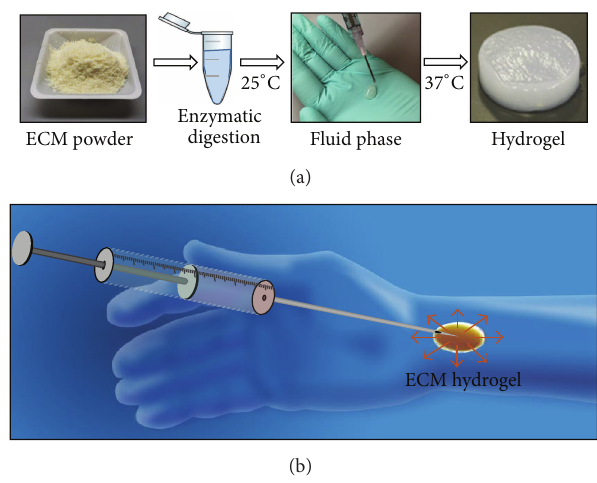
Figure 5: Minimally invasive delivery of ECM-based hydrogels. (a) ECM-derived hydrogels can be manufactured via enzymatic digestion of powdered ECM in an acidic 1mg/mL pepsin